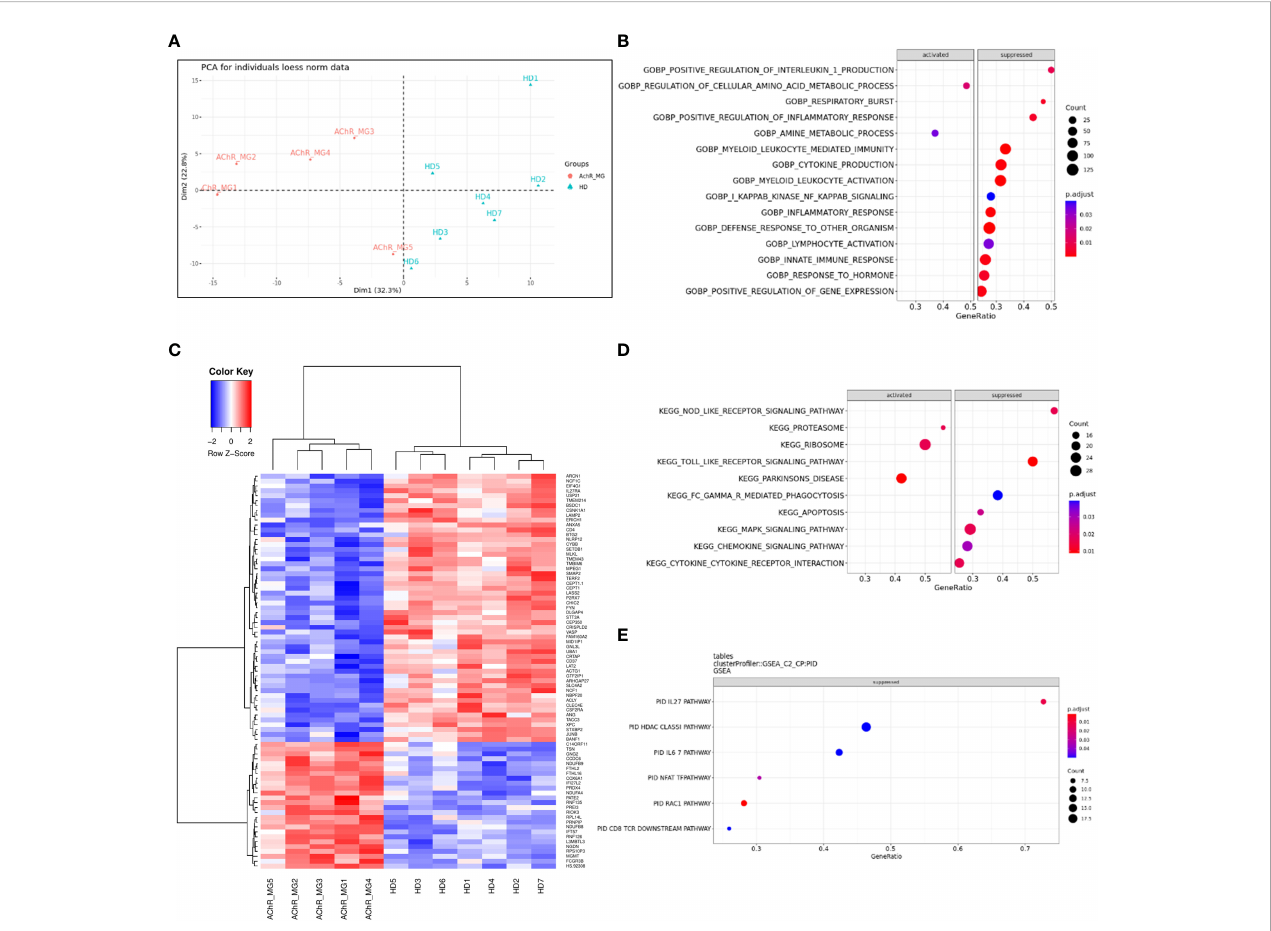
FIGURE 7 Dysregulated genes and pathways in monocytes from transcriptomic data. Principal component analysis of 200 most variable genes in the transcriptome (loess normalized expression). PC1, representing the majority of explained variances (32.3%), separates groups of anti-AChR positive and healthy subjects (A) . Unsupervised clustering of the top 100 most signi fi cant differentially expressed genes reveals similarity between groups of subjects (columns) and identi fi es top differentially up-regulated and down-regulated genes in circulating monocytes of patients (rows). Distance between features was measured by (1 - Kendall ’ s t correlation coef fi cient) and clustering was performed using the Ward.D2 method. Similar results were obtained with alternative distance de fi nitions and clustering procedures (not shown) (B) . Dot plot showing pathways that show a tendency for enrichment, determined from GSEA. Each dot plot demonstrates enriched pathways in subset gene sets from GO Biological Process ontology (C) , subset gene sets from PID pathway database (D) , and subset gene sets from KEGG pathway database (E) . The size of the dot represents gene count, and the color represents the adjusted